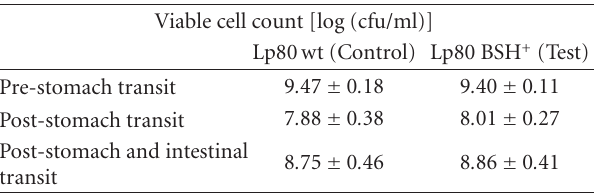
Table 1: Survival of microencapsulated L. plantarum 80 wild-type (control) cells and microencapsulated L. plantarum 80 BSH + (test) cells after simulated stomach (60 minutes) and intestinal (10 hours) transit during bile salt hydrolase assay.